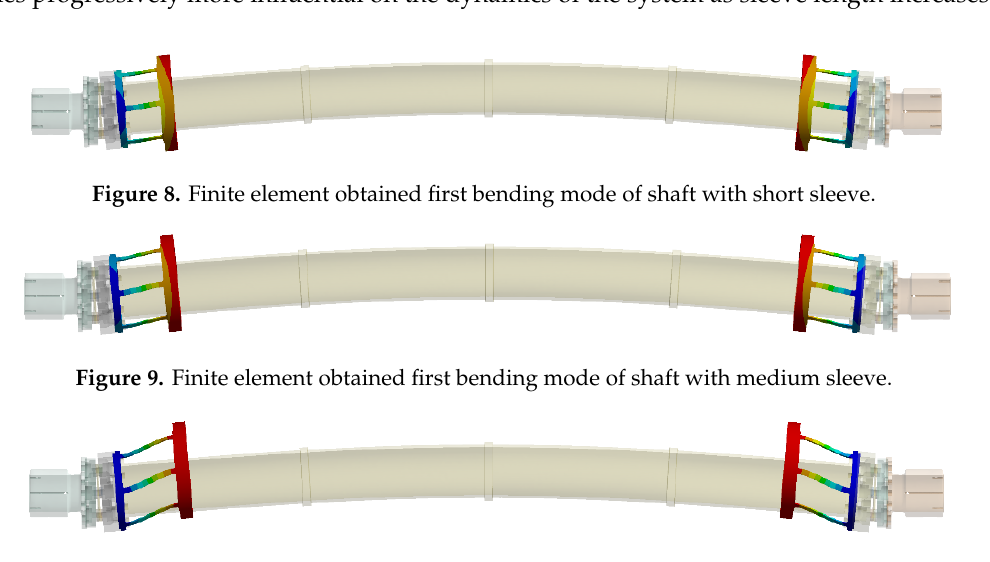
Figure 10. Finite element obtained first bending mode of shaft with long sleeve.